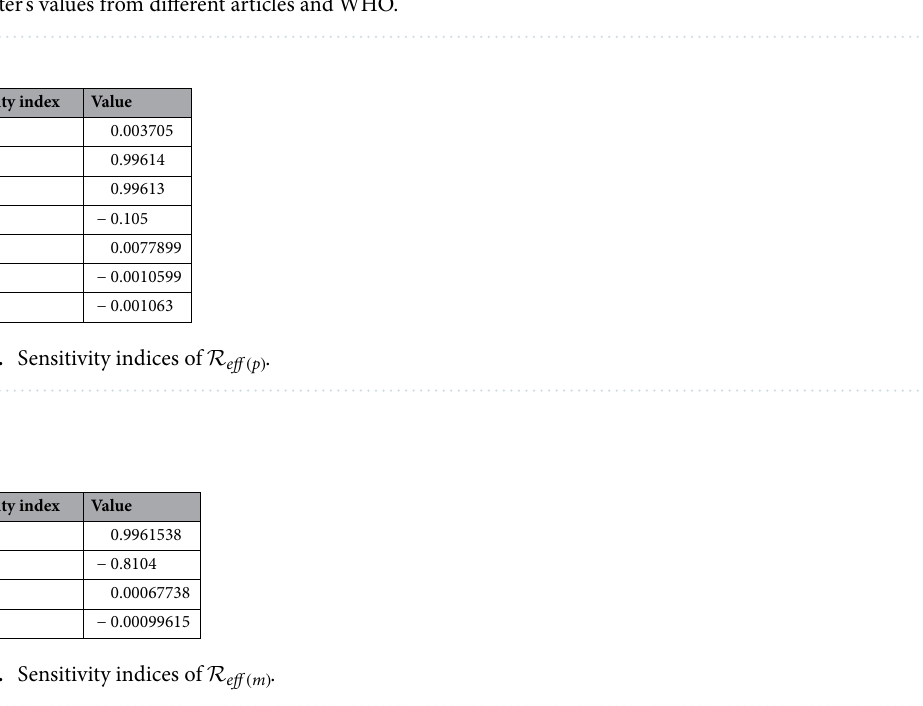
Table 2. Parameter values (NB: WHO’s 2019 relevant demographic data about Ethiopia are used). The parameter’s values from different articles and WHO.